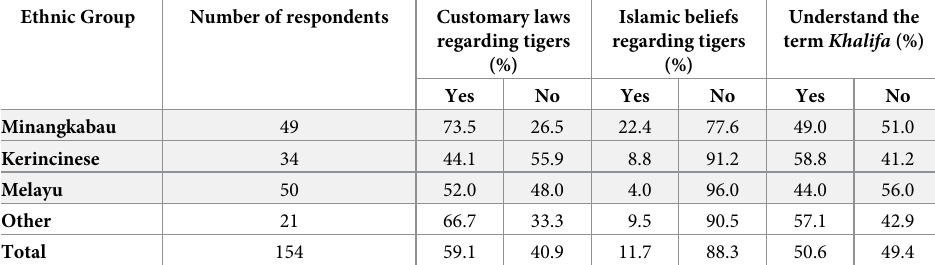
Table 2. The percentage of interviewees from different ethnic groups reporting the existence (Yes) or absence (No) of tiger-specific customary laws and Islamic beliefs together with the prevalence of khalifa understanding. Ethnic Group Number of